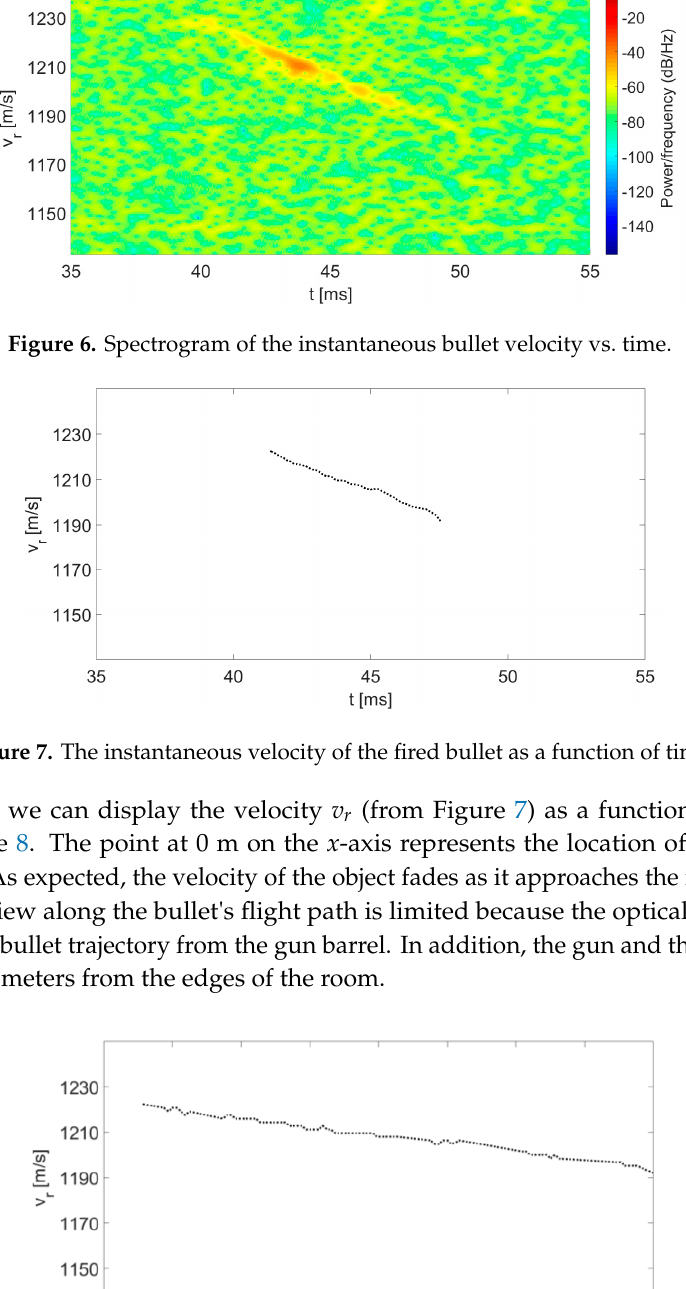
Figure 9. Illustration of the distance between the moving target to the radar r and the initial point d .